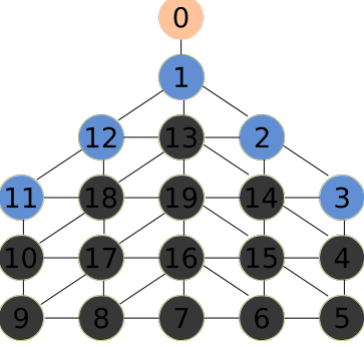
Figure 9. Lines divide the environment in rows and